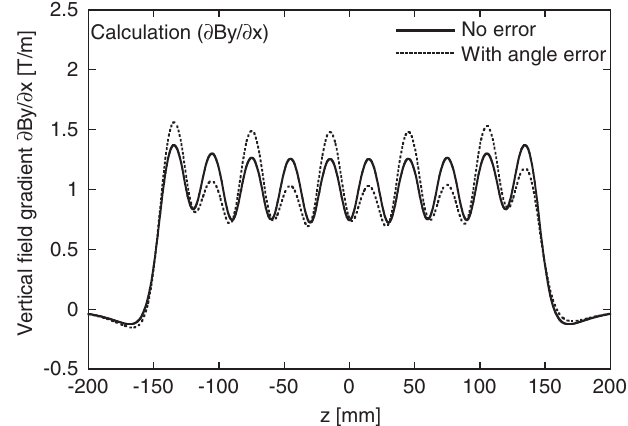
FIG. 18. Vertical field gradients ( @By=@x ) calculated along the wiggler axis with no error (solid line) and with an orientation ¼ 5 : 0 mrad and (cid:8) ¼ (cid:5)= 2 in the linear stage for the error of c x x horizontal direction x .